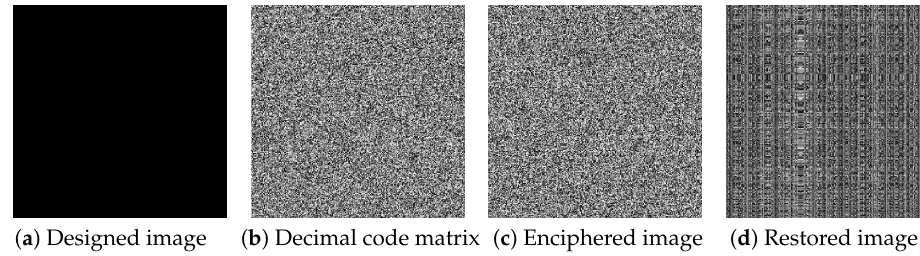
Figure 9. CPTAA for Lena ( 256